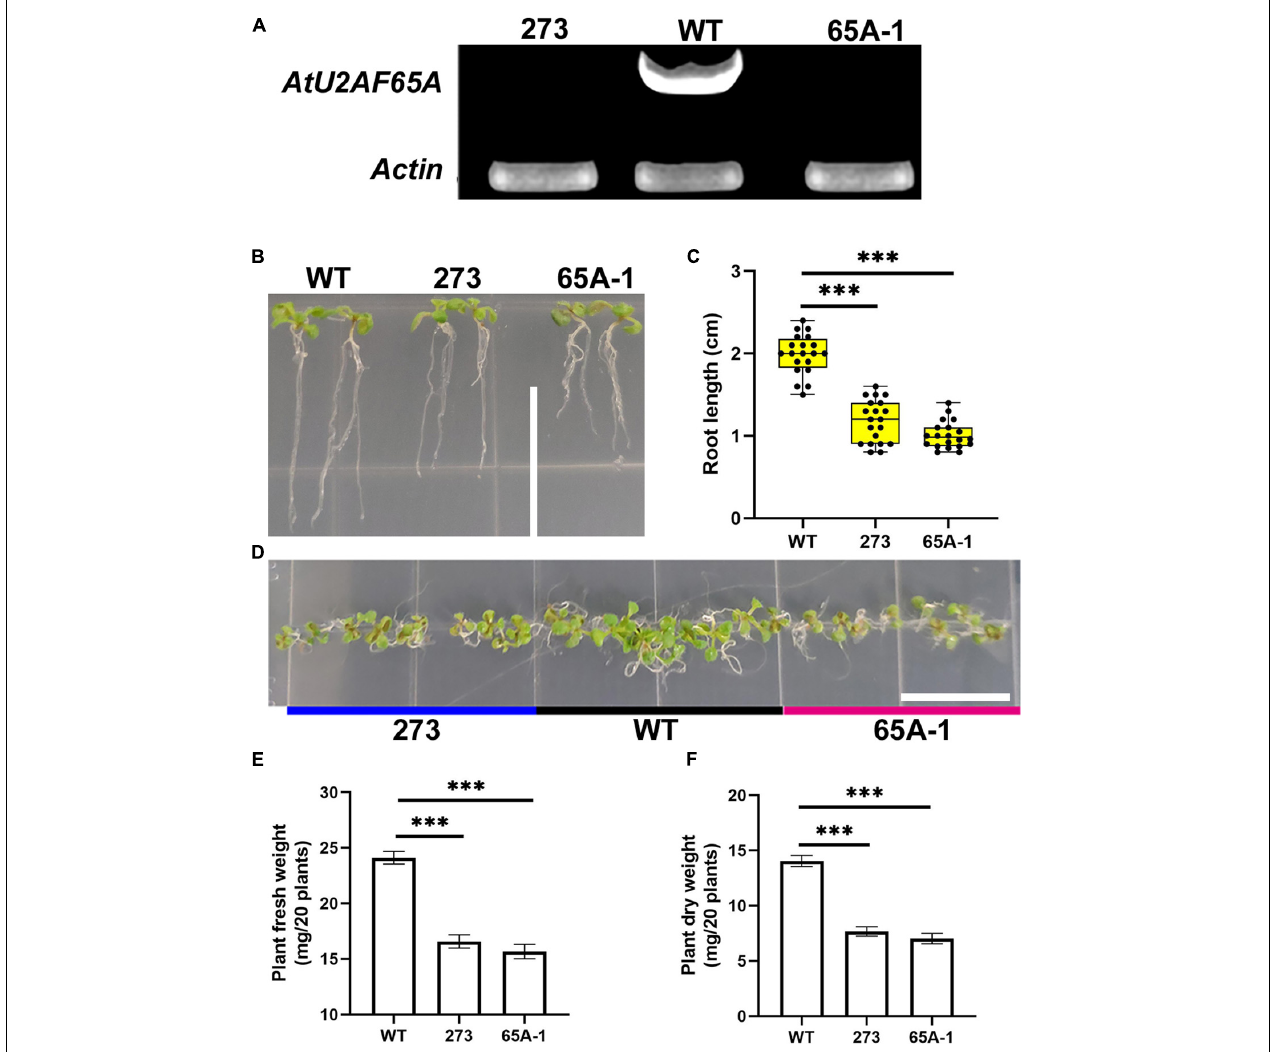
FIGURE 8 | AtU2AF65A mutations inhibit plant development. (A) Arabidopsis mutants were identified using RT-PCR. (B) Phenotype of Arabidopsis thaliana seedlings growing vertically for 9 days; bar = 14 mm. (C) Root length of plants (20 plants per repetition). (D) Phenotype of Arabidopsis thaliana seedlings growing horizontally for 9 days; bar = 14 mm. (E) Fresh weight of 20 Arabidopsis plants growing vertically for 9 days. (F) Dry weight of 20 Arabidopsis plants growing vertically for 9 days. Experiments in (B,D) were repeated three times with similar results. Data in (C,E,F) are presented as the means ± SD of three independent experiments, and differences between the 273/65A-1 mutants and wildtype are indicated by asterisks ( ∗∗∗ p < 0.001) according to ANOVA and Tukey’s post hoc